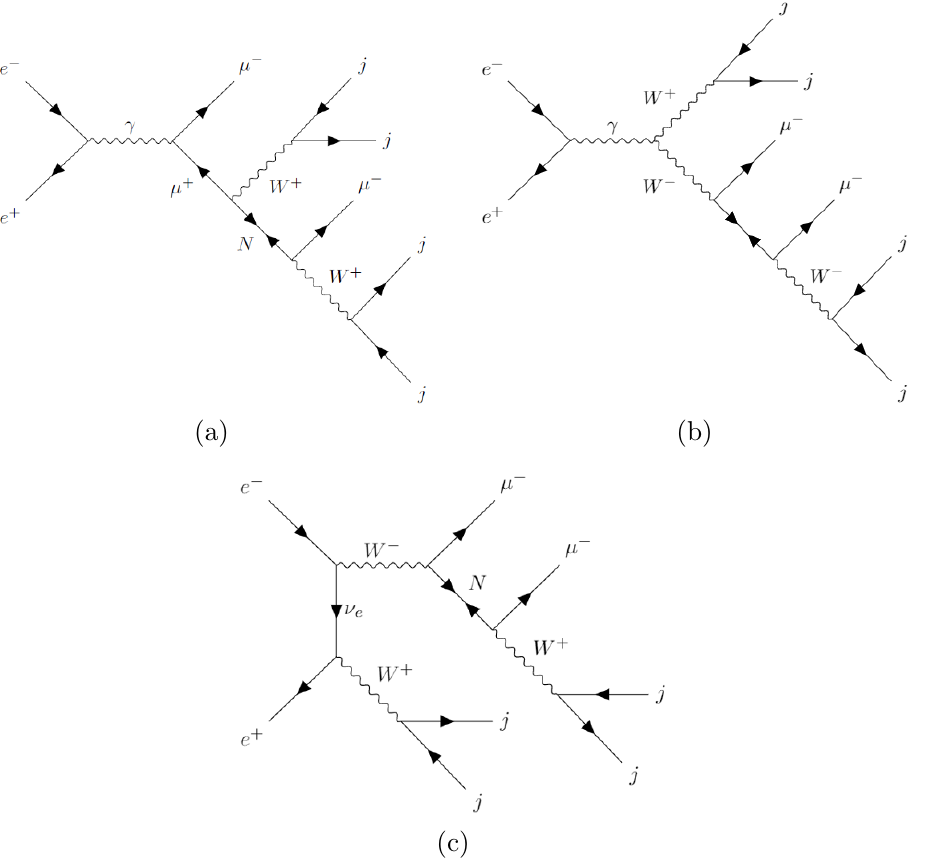
Figure 2 . Three sample Feynman diagrams for the process e + e (cid:0) ! N(cid:22) (cid:6) W (cid:7) ! (cid:22) (cid:6) (cid:22) (cid:6) + 4 j .